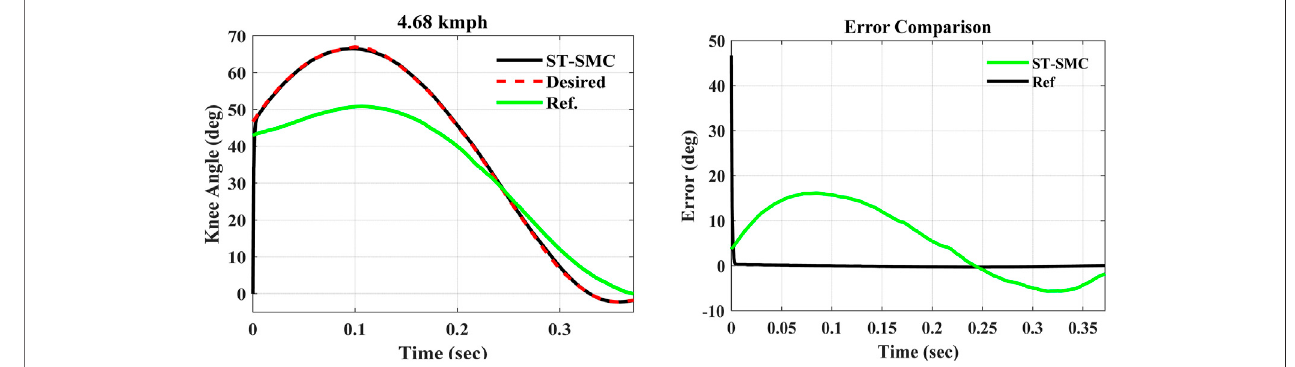
FIGURE 6 | Comparison of tracking ef fi ciency and error with the former design.